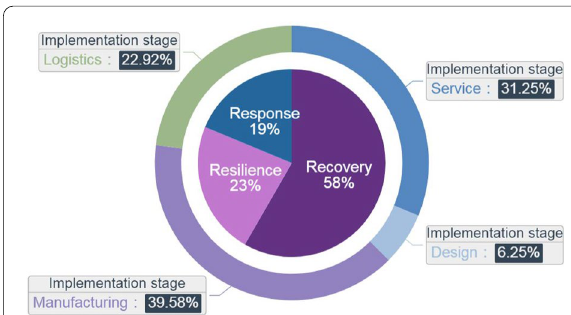
Figure 2 A pie chart for industrial cases of 3Rs